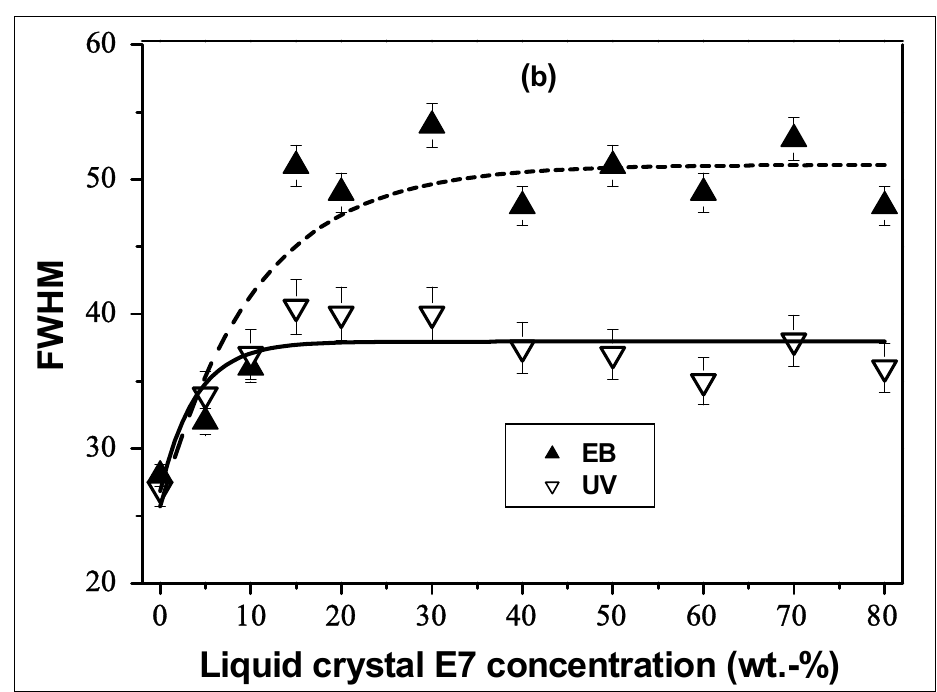
Figure 3. ( a ) Reduced T gR , and ( b ) Full Width at Half Maximum (FWHM) of tan δ around (T g (polymer)) as functions of LC concentration for both EB- and UV- cured TPGDA/E7.